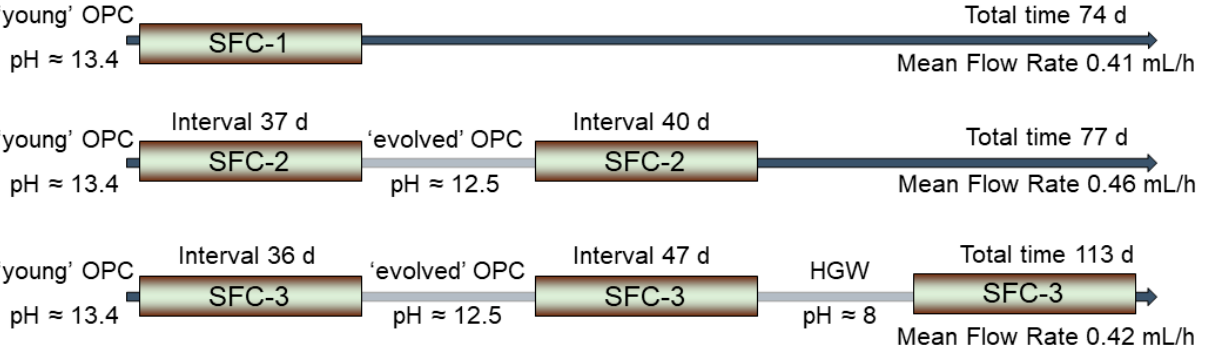
Figure 2. Details of the experiments, with interval and total times for the sequential experiments with the Horonobe mudstone reacting with OPC leachates and then ground water.